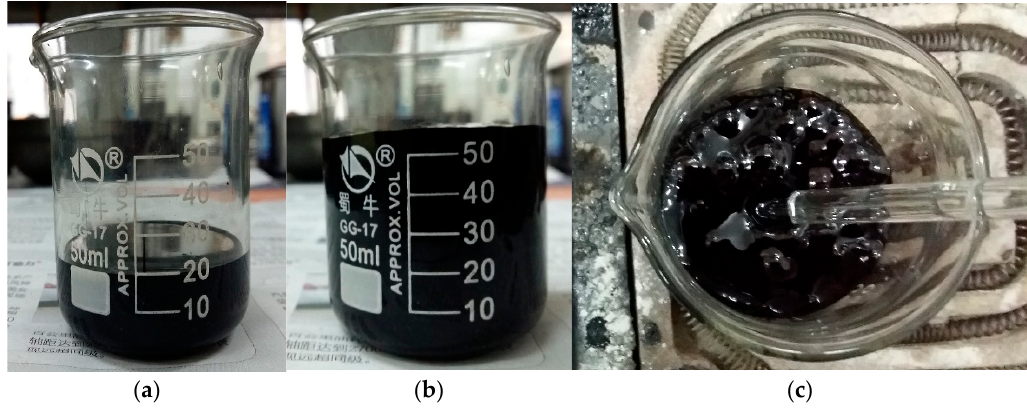
Figure 1. Boiling effect phenomenon. ( a ) Volume of 1% GO-modified asphalt before heating; ( b ) volum of 1% GO-modifed asphalt after heating; and ( c ) gas released.